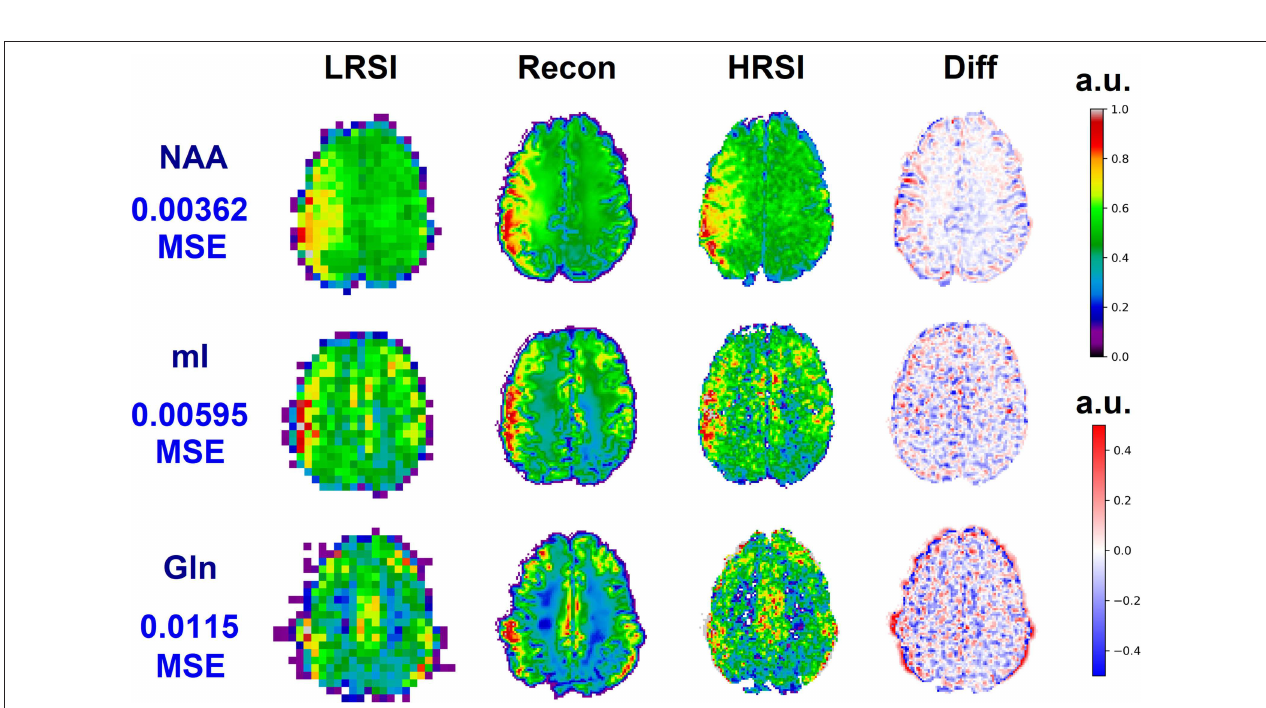
FIGURE 9 | Three reconstructions showing low MSE (top), average MSE (middle), and large MSE (bottom) are shown for three different volunteers. In general, lower MSE were observed for metabolites with higher signal-to-noise ratios such as NAA, whereas larger MSE values were calculated for low SNR metabolites such as Gln. The different MSE values are highlighted by the errors seen in the difference maps.